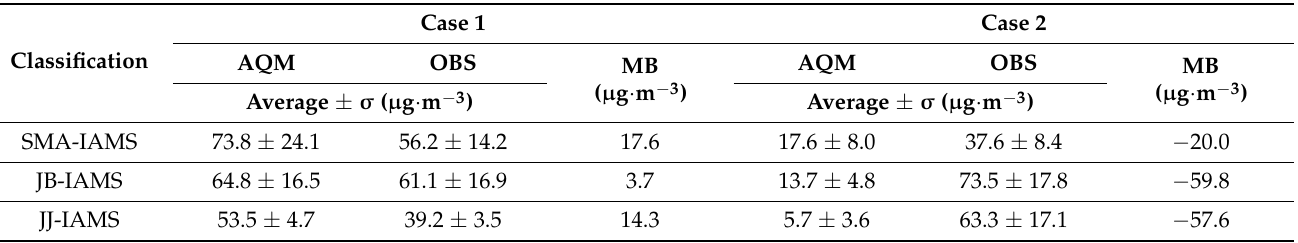
Table 2. Average of PM 2.5 concentrations of the air quality model (AQM), observations (OBS), and the mean bias (MB) during Case 1 and Case 2 at SMA-IAMS, JB-IAMS, and JJ-IAMS.